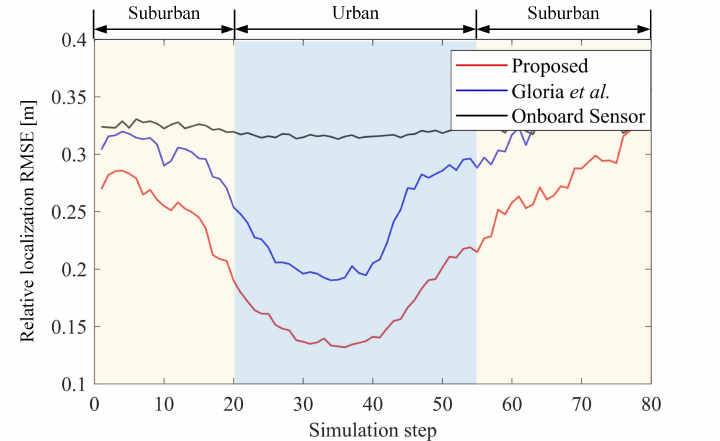
Figure 8. Relative positioning error of surrounding targets.